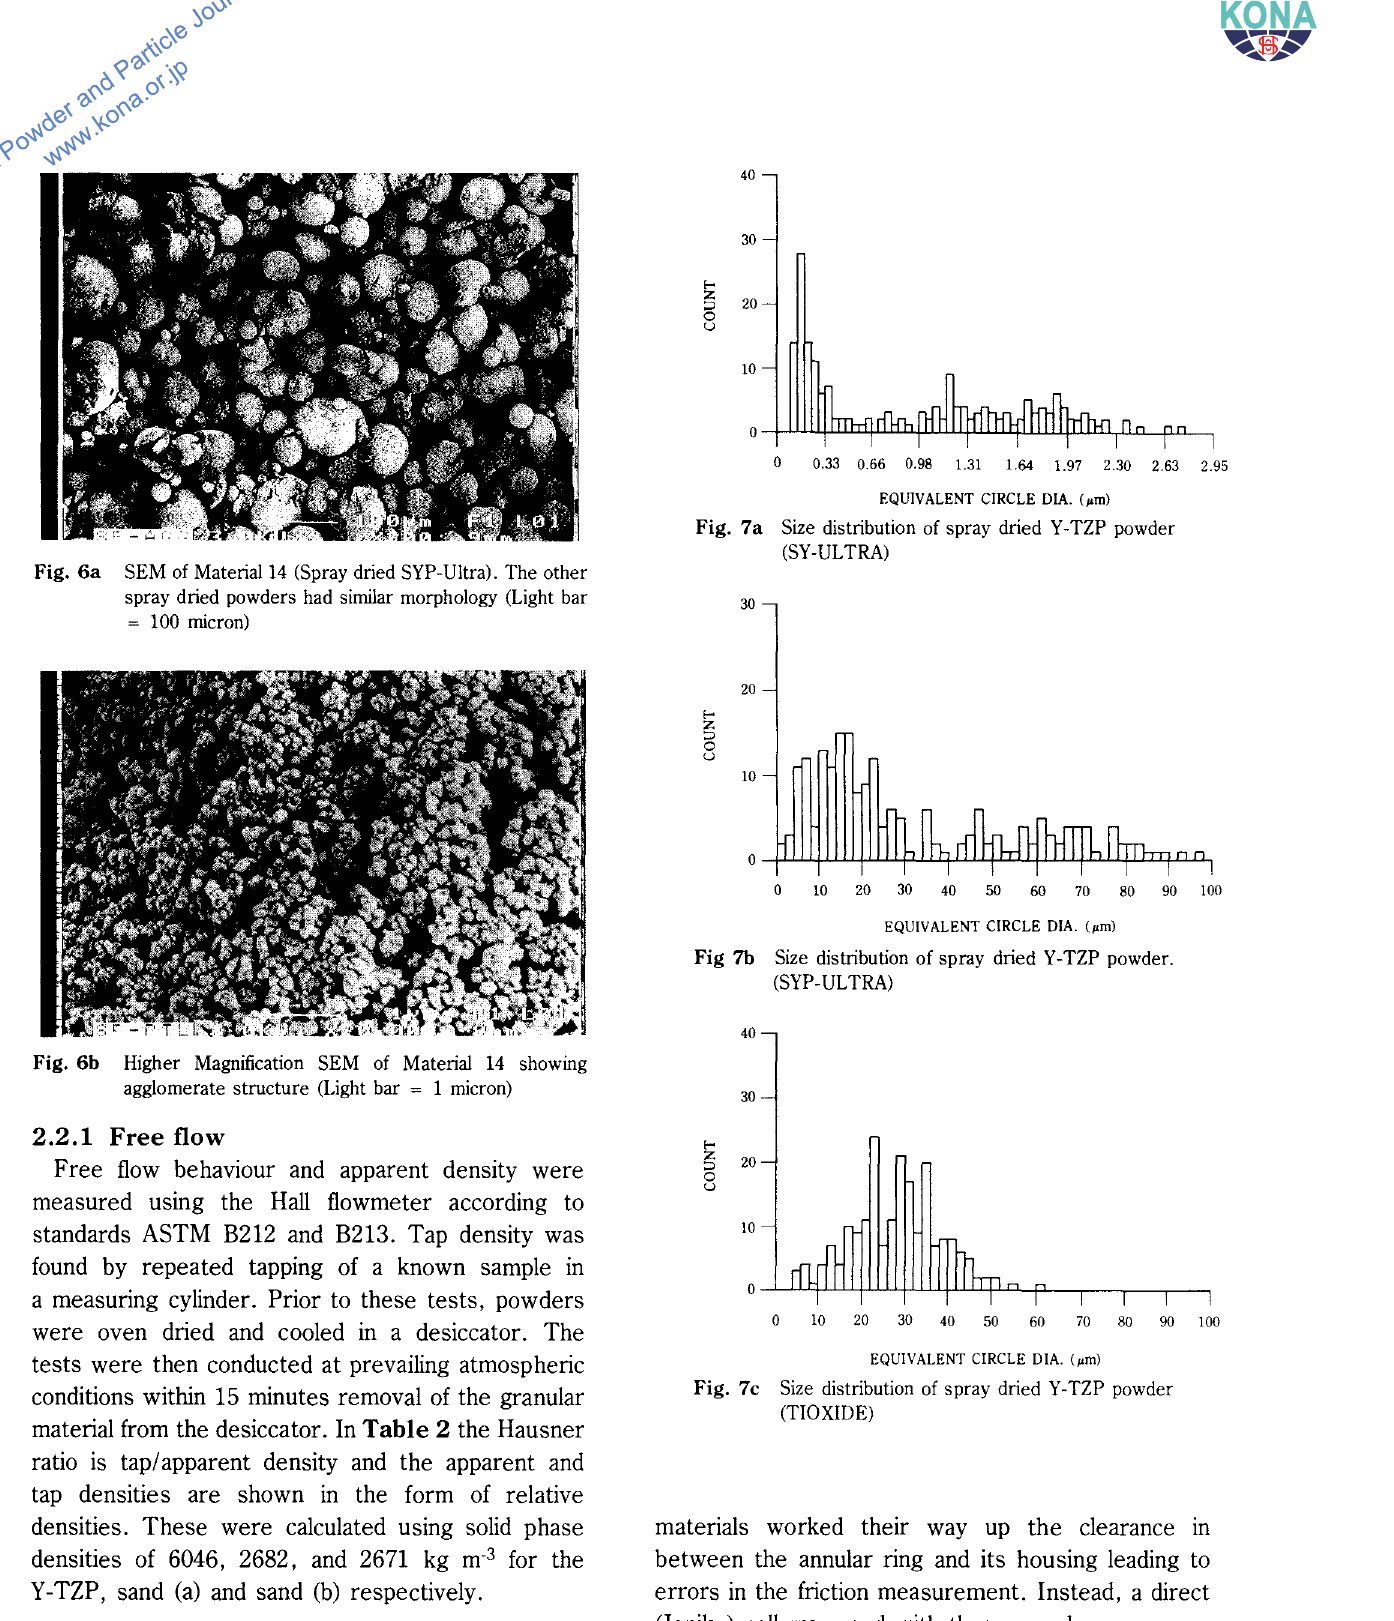
Fig. 7c Size distribution of spray dried Y-TZP powder